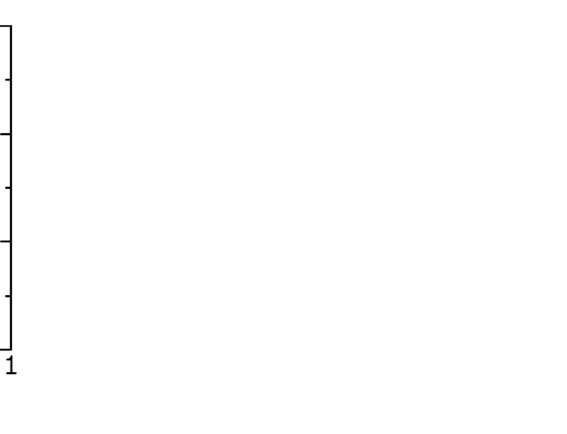
Figure 3. Dependence of C 1Hz on concentrations of KCl. The inset is the plot of log ( C 1Hz − C Hlm ) against log c with the slope 0.70.